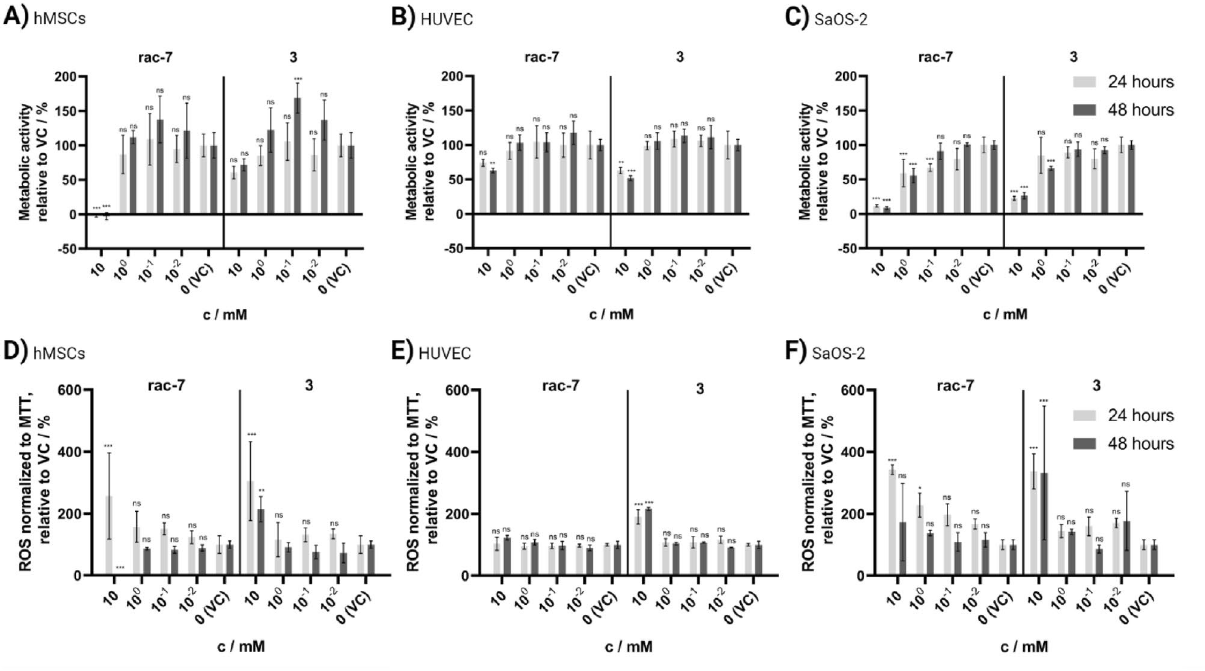
Figure 3. Biocompatibility of the compounds rac-7 and 3 . Human mesenchymal stem cells (hMSC), human umbilical vein endothelial cells (HUVEC) and SaOS-2 human osteogenic sarcoma cells treated for 24 and 48 h. ( A – C ) Evaluation of metabolic activity at different concentrations of CSPs with MTT-assay in comparison to vehicle control (VC). ( D – F ) Cellular reactive oxygen species (ROS) normalized to MTT-assay and compared to VC. VC was treated with PBS instead of CSPs stock solution. Values are shown as mean ± SD (n = 3). Statistical significance was analyzed with Two-way ANOVA and Dunnett post-hoc test against respective VC ( ns